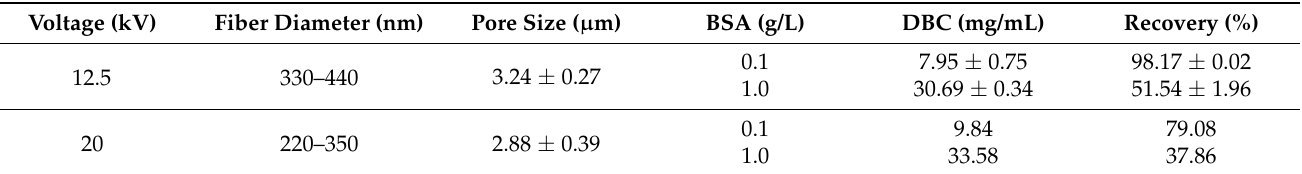
Table 5. The effect of fiber diameter on DBC and recovery.